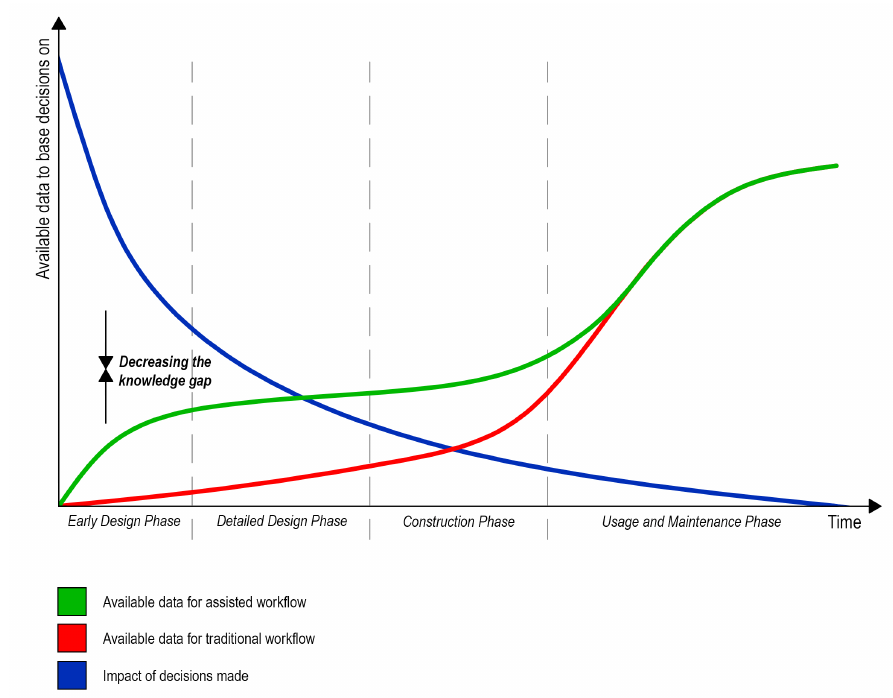
Figure 1. Available data for the proposed assisted workflow (figure based on data provided by Kohler and Moffatt [26] and Bragança et al.